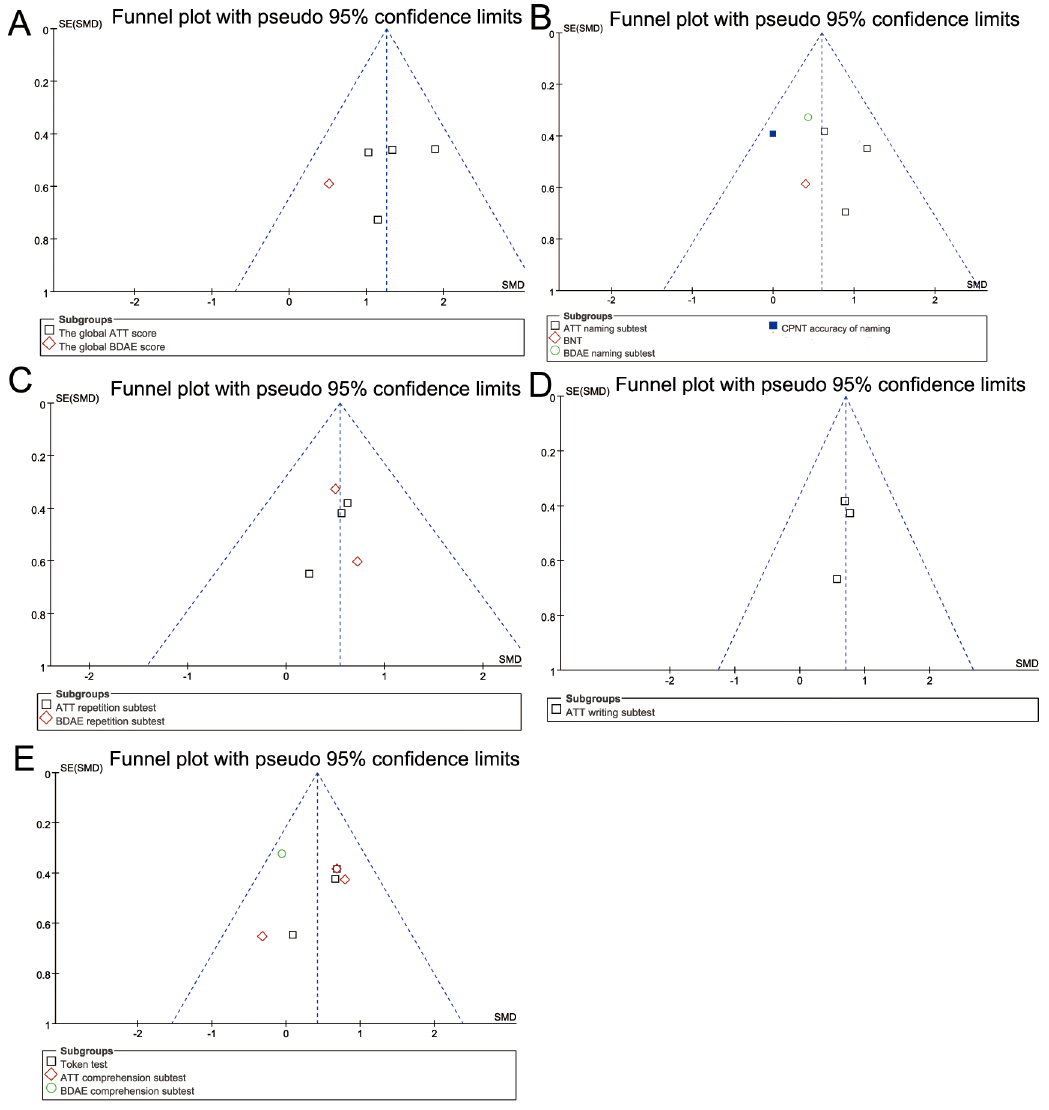
Figure 7. Funnel plots demonstrating publication bias for the severity of impairment (A), naming (B), repetition (C), writing (D), and comprehension